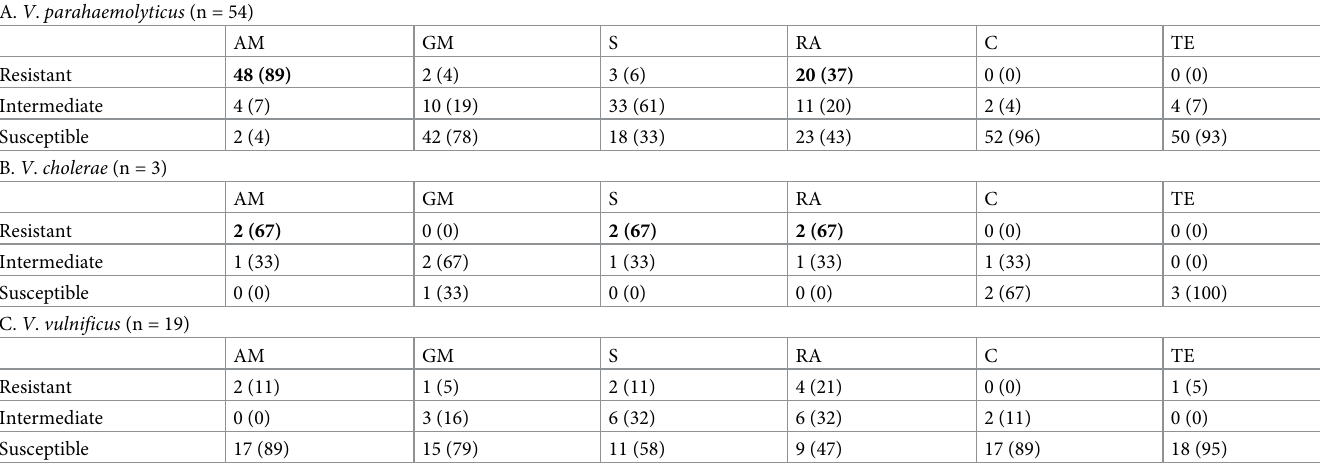
Table 2. Vibrio spp. isolates (n = 76) resistant, intermediate, or susceptible to ampicillin (AM), streptomycin (S), rifampin (RA), tetracycline (TE), gentamicin (GM), and chloramphenicol (C). Values are shown for number of isolates and corresponding percentage (in parentheses). Bolding indicates the most common forms of resistance. A) V . parahaemolyticus , B) V . cholerae , C) V . vulnificus